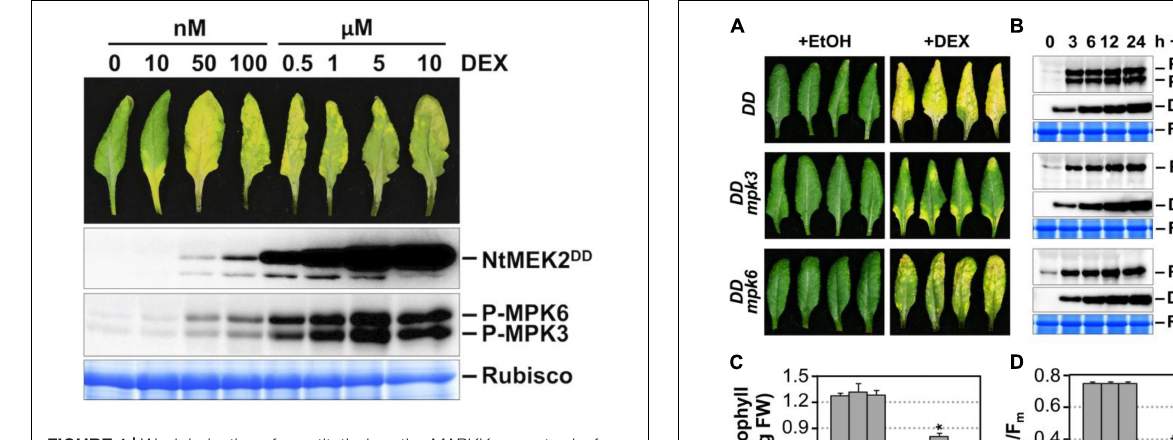
FIGURE 1 | Weak induction of constitutively active MAPKK promotes leaf senescence. Treatment of DD plants with different concentrations of DEX can control the amplitude of MPK3/MPK6 phosphorylation/activation. Fully expanded leaves from 4-week-old soil-grown plants were detached and their petioles were inserted into 0.6% agar medium with different concentrations of DEX. Photos were taken at 3 days after DEX treatment (first panel). Leaves treated with DEX at 0.5 µ M or above showed rapid cell death and stayed green. Leaf samples were collected at 1 day after DEX treatment. DD protein induction was detected by immunoblot assay using an anti-flag antibody (second panel). MAPK activation was detected by immunoblot assay using an anti-pTEpY antibody (third panel). Coomassie brilliant blue staining of a duplicated gel was used to confirm equal loading (fourth panel).